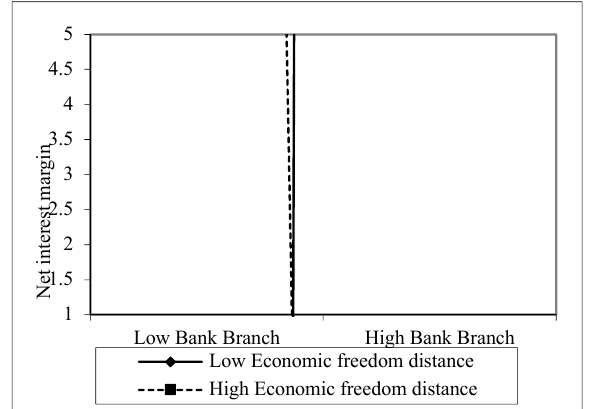
Figure 6. Bank Branch × Institutional Distance.